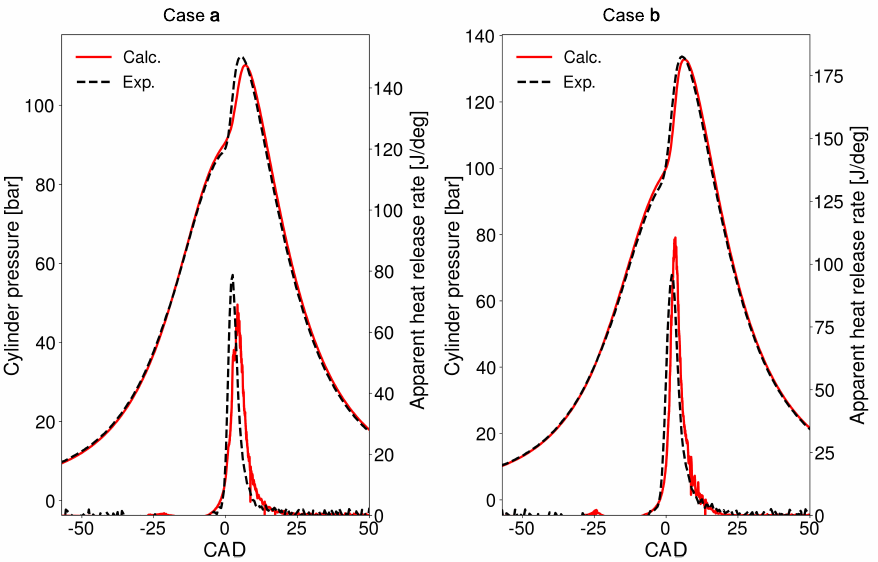
Figure 5. Validation of computed in-cylinder pressure and HRR with experimental results for (case a ) and (case b